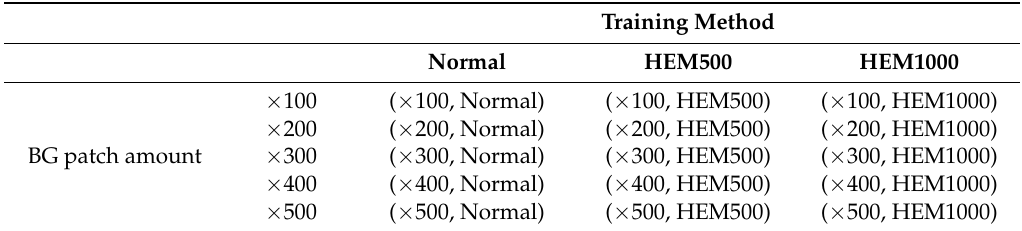
Table 2. Experimental conditions, which are combinations of the training method and the background patch amount. Each pair in parentheses expresses one experimental